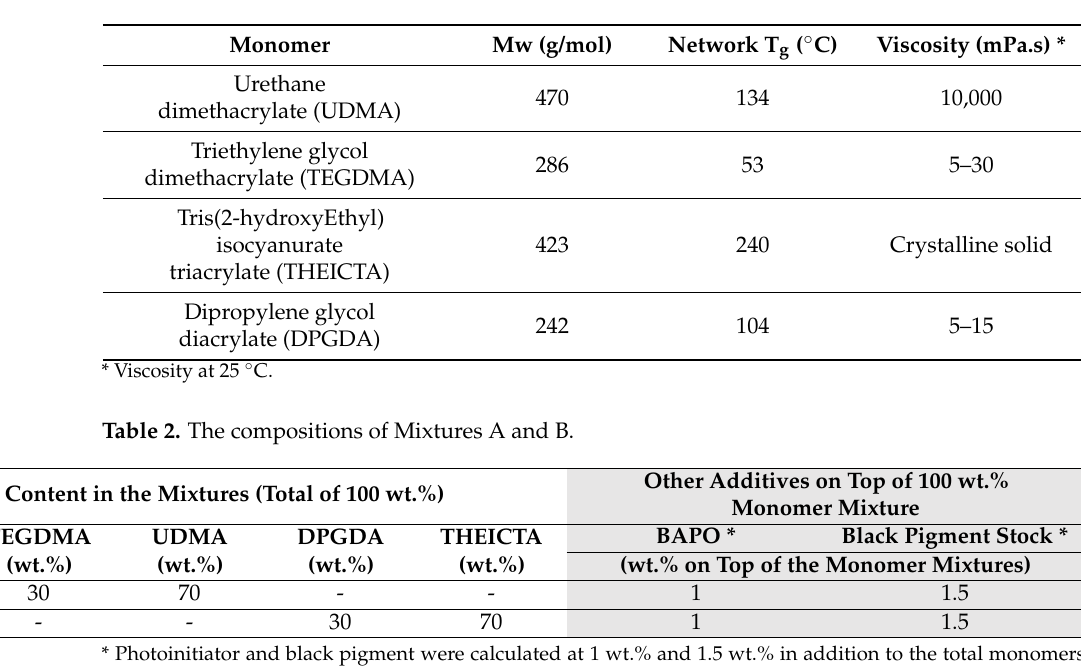
Table 1. The characteristics and chemical structures of the monomers.